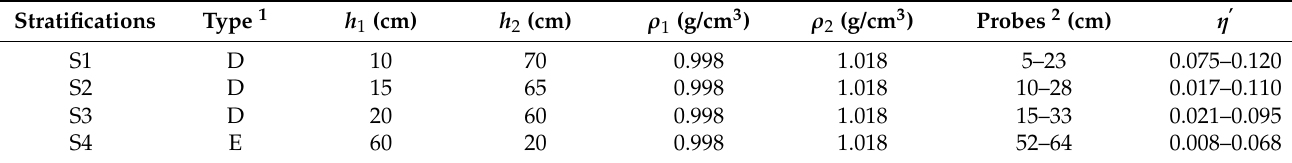
Table 1. Summary of experimental